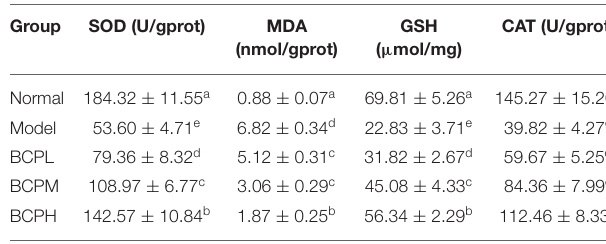
TABLE 6 | SOD, MDA, GSH, and CAT contents of H9c2 cells with OS